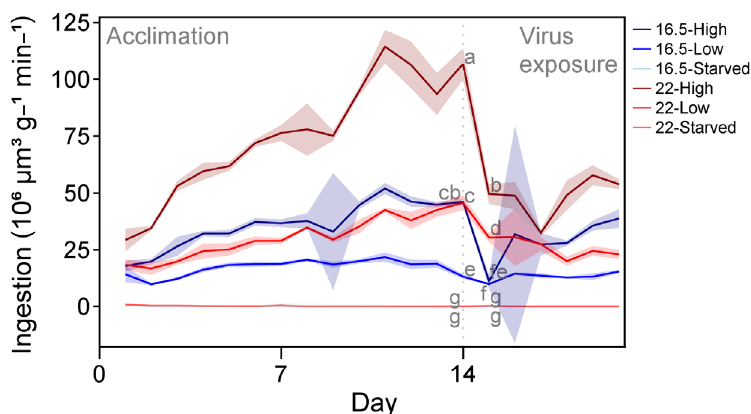
Fig. 3. Ingestion rate of phytoplankton for oysters as a function of temperature (16.5 and 22°C) and food level during the acclimation period (0−14 d) and virus exposure (14−20 d). Values are means ± 95% confidence intervals (n = 3 tanks). Lowercase letters indicate significant differences occurring at the on- set of virus exposure. Data from oysters kept under starvation at both tem- peratures are indistinguishable and close to